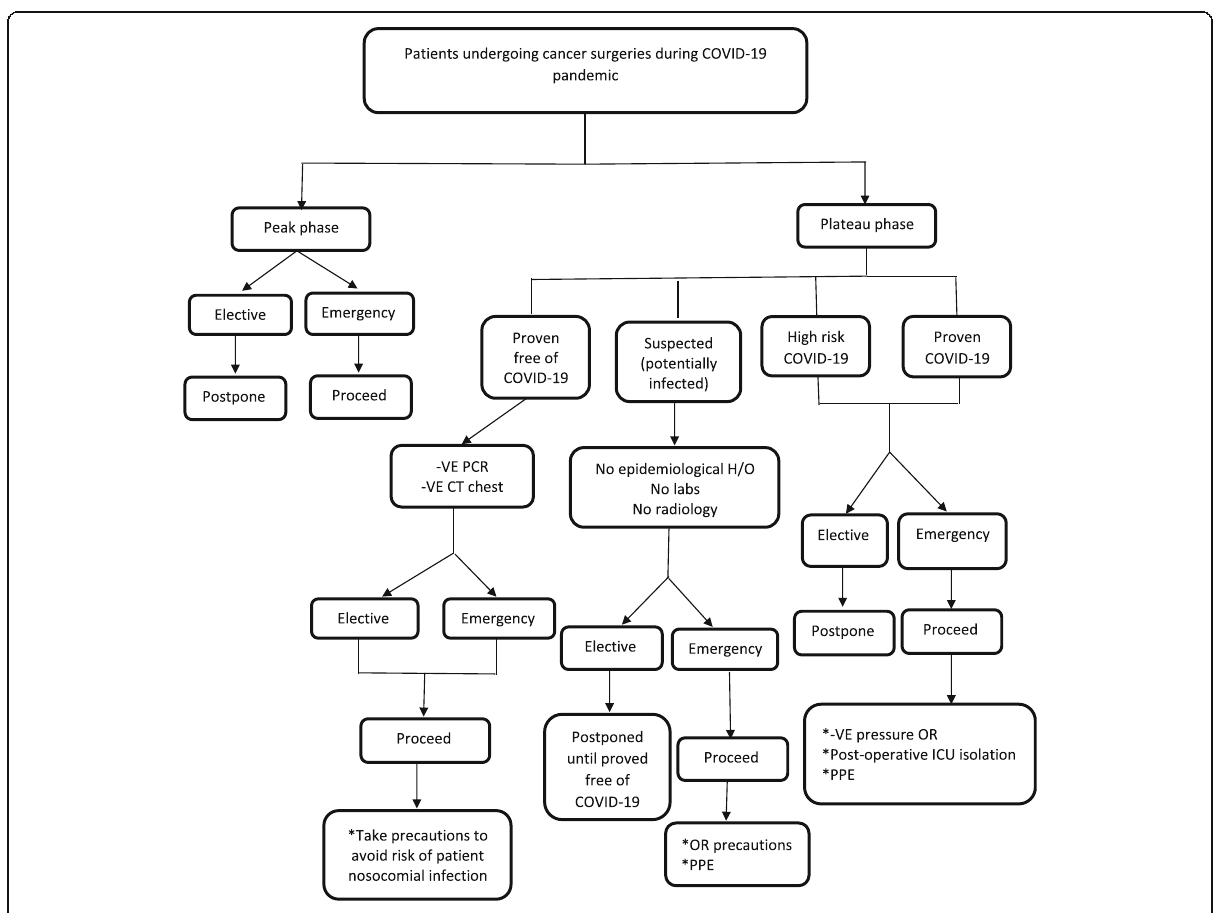
Fig. 1 Patients undergoing cancer surgeries during COVID-19